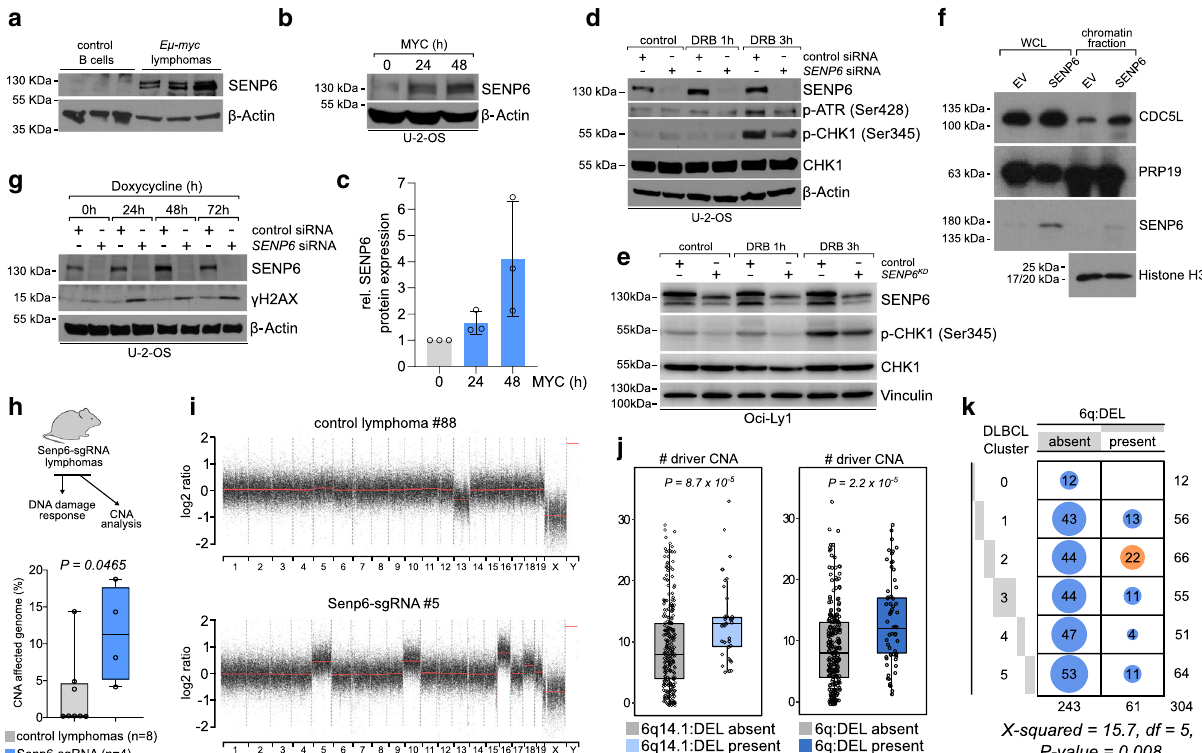
Fig. 5 SENP6 is activated by MYC and controls DNA damage checkpoint activation. a Immunoblot analysis of the indicated proteins in splenic CD19 + B-cells ( n = 3) puri fi ed from wild-type mice and in E µ -myc lymphomas ( n = 3). b Immunoblot analysis of indicated proteins in U-2-OS cells after induction of MYC for the indicated times. c Quanti fi cation of the SENP6 western blots in U-2-OS cells after induction of MYC for the indicated times. Protein expression of SENP6 at 0 h was arbitrarily set to 1. Data are presented as mean ± SD from n = 3 independent experiments. d Immunoblot analysis of indicated proteins in U-2-OS cells after transfection with speci fi c SENP6 siRNA or control siRNA and doxorubicin (DRB) treatment for the indicated times.